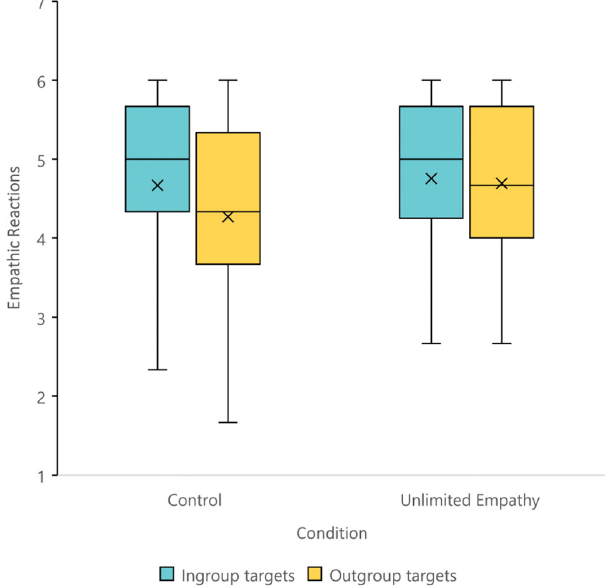
Fig.8|Empathicreactionstowardingroupandoutgrouptargets,asafunction of condition (i.e., unlimited empathy, n =88; and control, n =84). A signi fi cant target identity×condition interaction , F (1, 170)=5.09, p =0.025, d =0.35. A sig- ni fi cant difference in empathy toward ingroup and outgroup members among participants in the control condition ( p <0.001). No signi fi cant difference in empathy towards ingroup and outgroup members among participants in the unlimited condition ( p =0.344). The plot presents the maximum and minimum values as whiskers, the interquartile range as the vertical length of each box, the mean as the x marker, and the median as the horizontal line within each box. All tests are two-tailed. Source data are provided as a Source Data fi le.